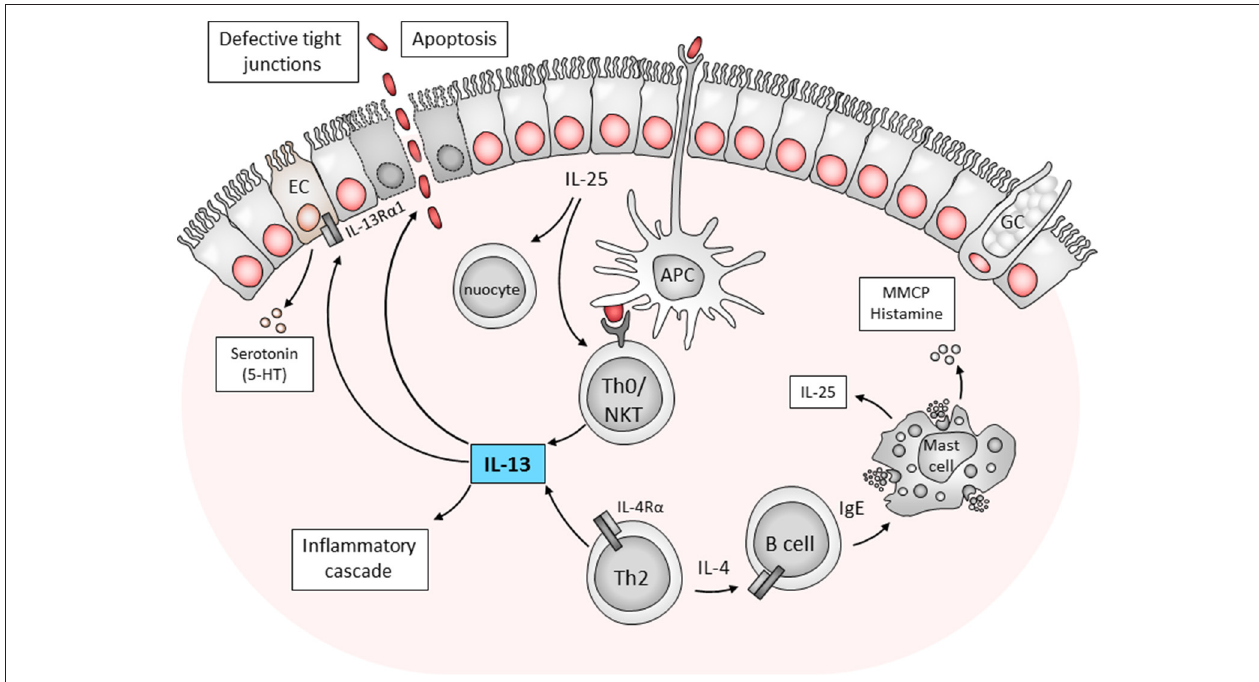
FIGURE 1 | Immune components contributing to ulcerative colitis. The mechanisms of pathogenesis is postulated as follows; a defect in antigen sampling by antigen presenting cells (APCs) or direct stimulation from epithelial cells activates Th0 cells or NK T cells to drive a Th2/type 2 response. Here IL-25 production by epithelial cells was also linked to disease pathology through nuocytes and NK T cells. NK T cells produce IL-13 which is toxic to epithelial cells. Furthermore, conventional CD4 + Th2 cells which produce IL-4 can also stimulate B cells to drive inflammation in an IgE-dependent manner. These findings indicate the complex interaction of host cells in the development of ulcerative colitis. APC, antigen presenting cell; EC, enterochromaffin cell; GC, goblet cell; IL, interleukin; MMCP, murine mast cell protease; NKT, natural killer T cell; Th0, T helper type; 5-HT- serotonin 5-hydroxytryptamine (Heller et al., 2002; Ikeda et al., 2003; Ghia et al., 2009; Camelo et al., 2012; Hoving et al.,